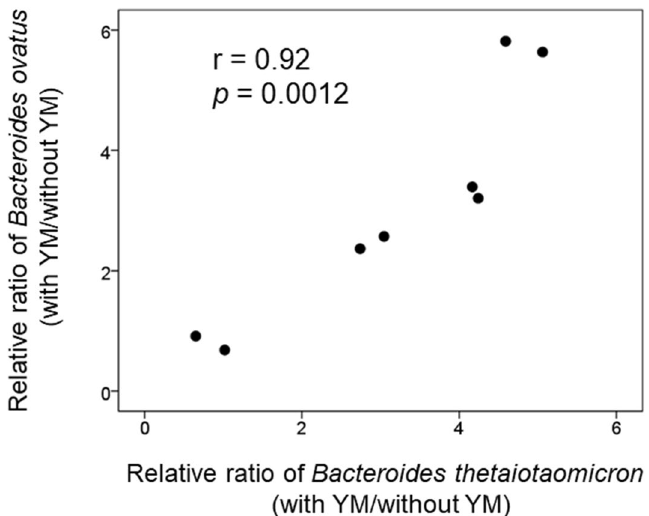
Figure 6. The correlation between the relative ratio of Bacteroides thetaiotaomicron and Bacteroides ovatus (with the 0.4% yeast mannan preparation [YM]/without yeast mannan [CUL]) in the KUHIMM after 30 h of fermentation (n = 8).